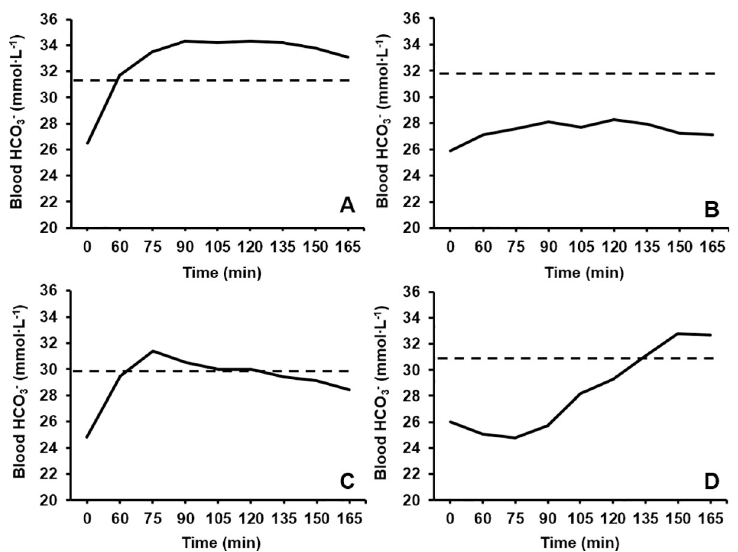
Fig 1. The time course change in blood bicarbonate (HCO 3– ) over a 165 min period following NaHCO 3 ingestion for A) participant 1, B) participant 8, C) participant 7, and D) participant 5. The dotted line represents a +5 mmol � L -1 increase from baseline blood HCO 3–